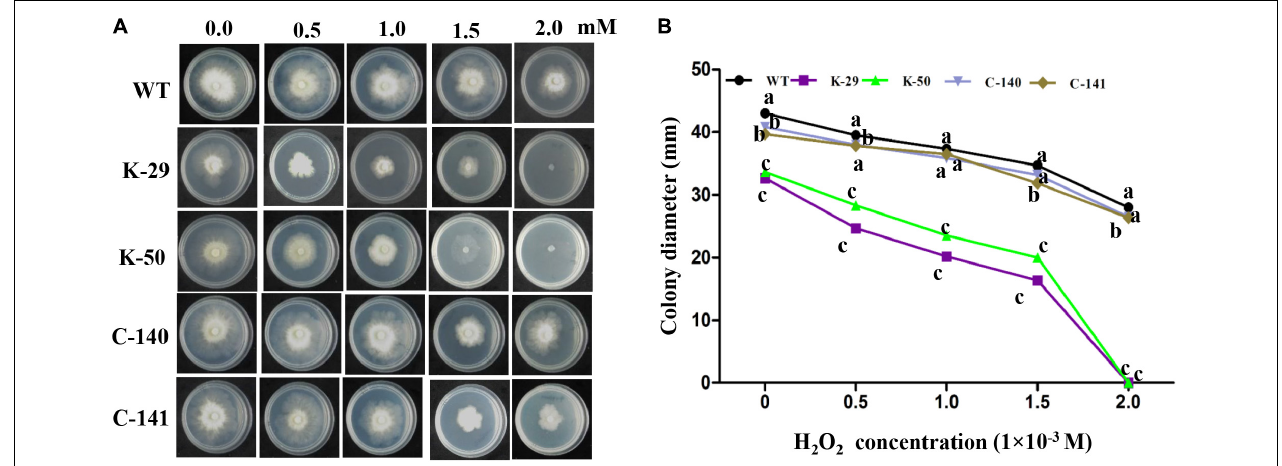
FIGURE 2 | Hypersensitivity of the (cid:49) VpFSTF1 mutant to H 2 O 2 . (A) Effect of oxidative stress on colony growth. Wild-type (WT), (cid:49) VpFSTF1 (K-29 and K-50) deletion mutant and VpFSTF1com (C-140 and C-141) complementation strains were grown on PDA medium supplemented with indicated H 2 O 2 concentrations and incubated at 25 ◦ C for 48 h. Representative photographs are shown. (B) Radial growth of different strains on PDA medium under oxidative stress compared with growth on PDA without oxidative stress. Colony diameters were measured at 48 h. Different letters indicate significant differences ( P < 0.05,